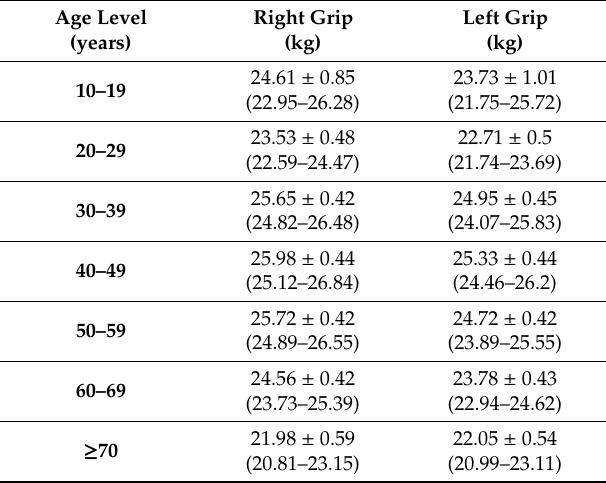
Table 4. The Normative Value of Grip Strength Adjusted for All Covariates in